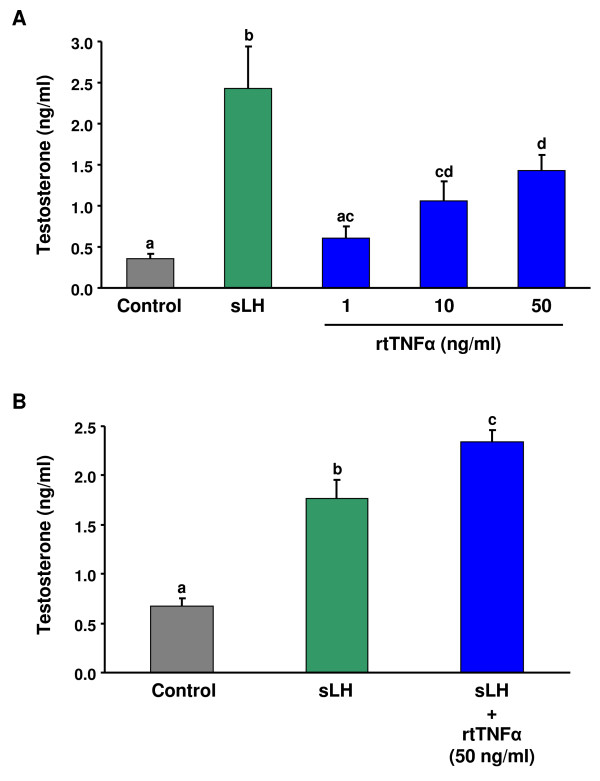
Steroid production of brown trout preovulatory follicles treated with rtTNFα in vitro. Preovulatory trout follicles were incubated in the absence or presence of coho salmon LH (sLH; 25 ng/ml), different concentrations of rtTNFα (1, 10 and 50 ng/ml) (A) or sLH in the absence or presence of 50 ng/ml of rtTNFα (B) for 24 h at 15°C. Testosterone levels were measured in the medium at the end of the incubation period. Each bar represents the mean ± SE of two independent experiments, each with ovarian tissue from a separate female and assayed in triplicate. Statistically significant (p < 0.05) differences among groups are indicated by different letters.